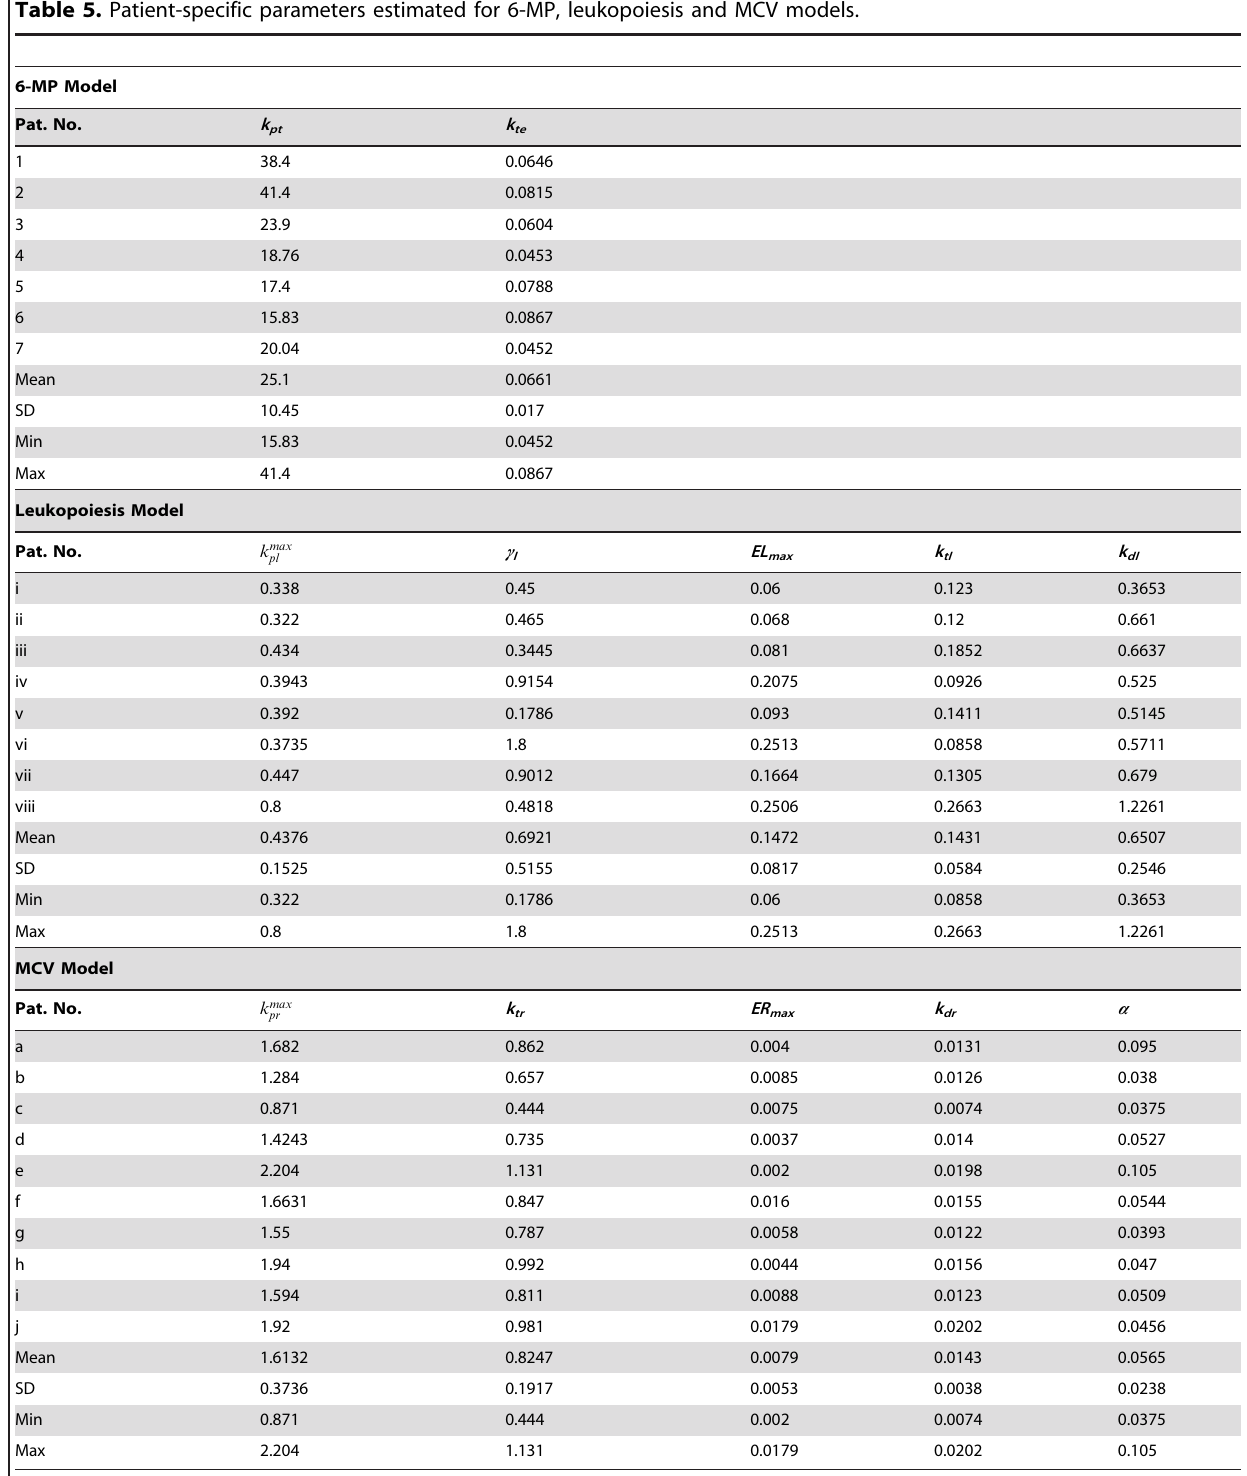
Table 5. Patient-specific parameters estimated for 6-MP, leukopoiesis and MCV models.